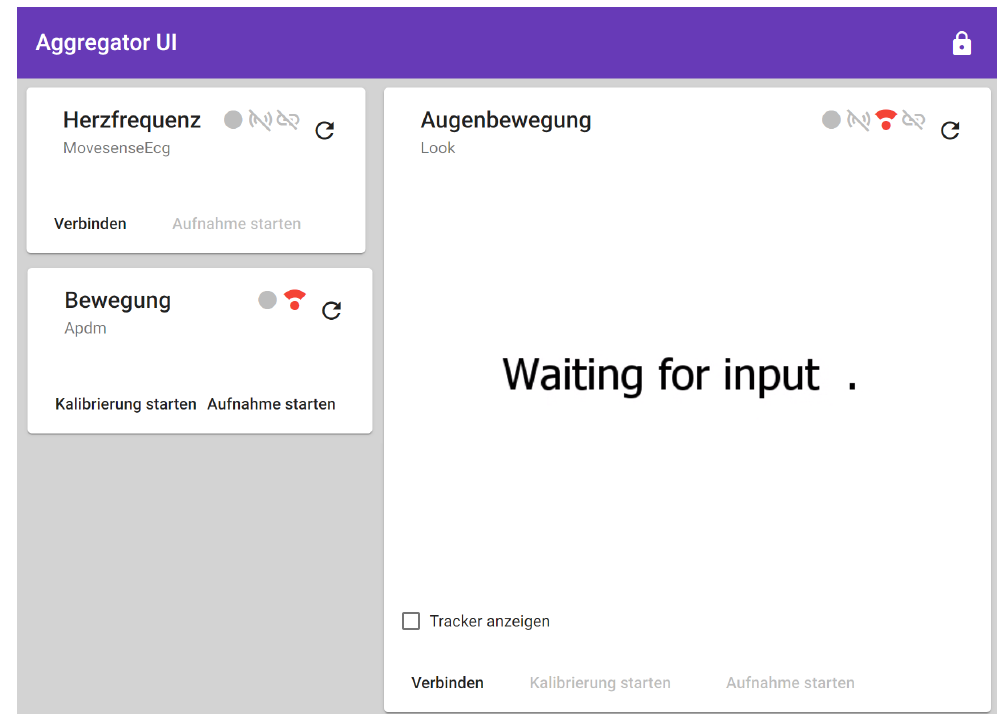
Figure 5. Aggregator Frontend with control tiles for each sensor driver.